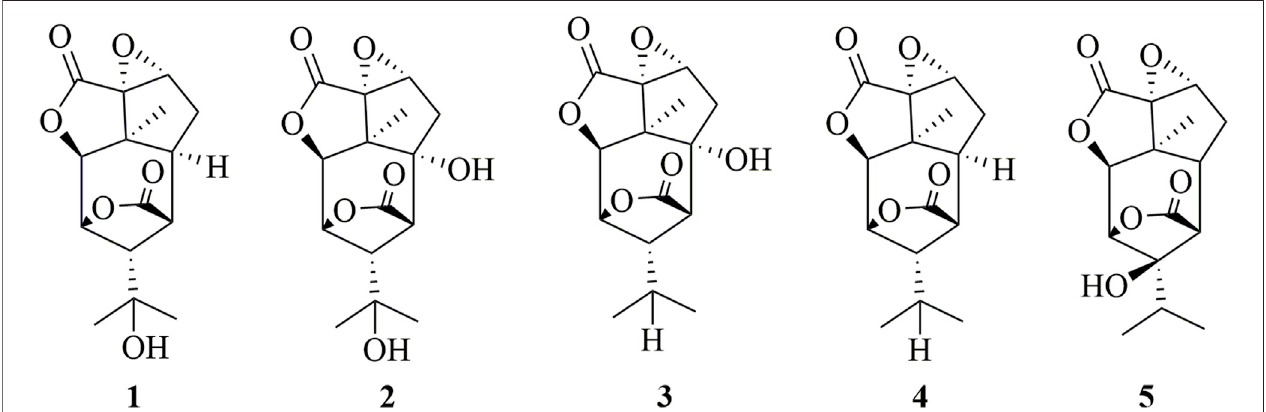
FIGURE 3 | Structure of sesquiterpenes ( 1 – 5 ) in D. huoshanense